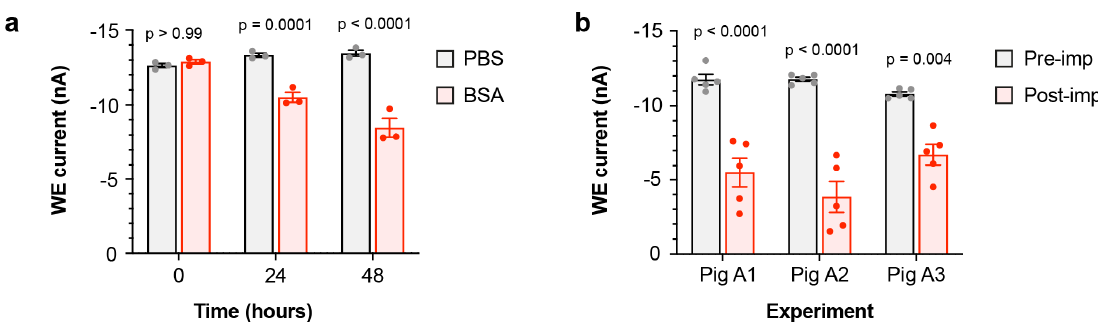
Figure 5. Effect of biofouling on sensor sensitivity. ( a ): In vitro assessment, showing mean steady-state WE current at 0, 24, and 48 h from sensors continuously immersed in either air-saturated PBS alone or air-saturated PBS with 35 mg/mL BSA ( n = 3 sensors/condition). ( b ): In vivo assessment, showing mean steady-state WE current from sensors in air-saturated PBS before and after implantation in pigs A1–A3 ( n = 5 sensors/pig).